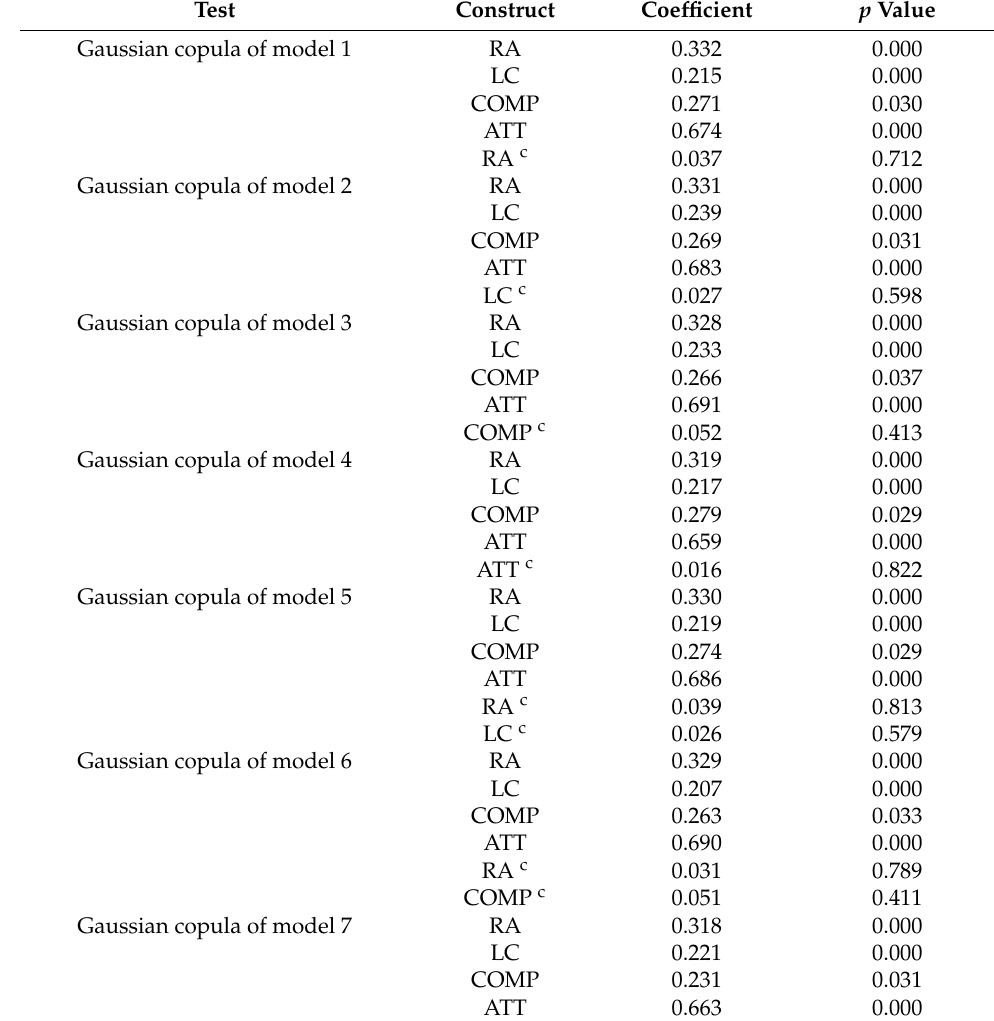
Table A1. Result of Endogeneity Test using the Gaussian Copula